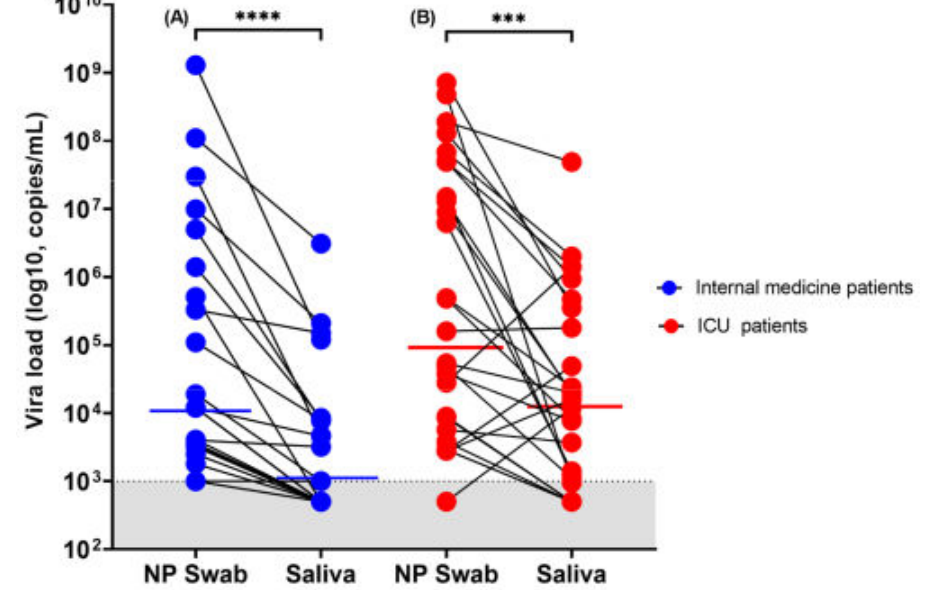
Figure 3. Viral load trend in person-matched NP and saliva samples ( n = 49). ( A ) Patients hospitalized in the internal medicine ward and ( B ) patients hospitalized in the ICU. The dotted line and shaded grey area delimit our assay’s detection limit. For graphical representation purposes, samples within the undetectable area are represented with values determined to be at 500 copies/mL. The red and blue horizontal lines represent median values (**** = p < 0.0001 and *** = p < 0.001 with Wilcoxon signed-rank